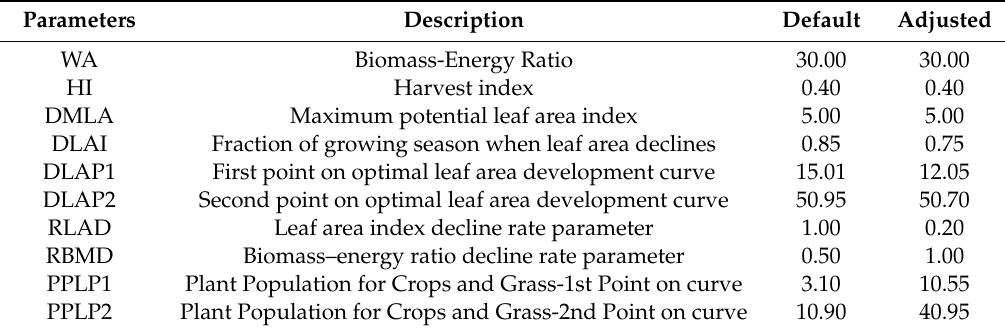
Table 3. Peanut plant parameters used to calibrate the Agricultural Policy Environmental eXtender (APEX) model. The adjusted parameters are shown in